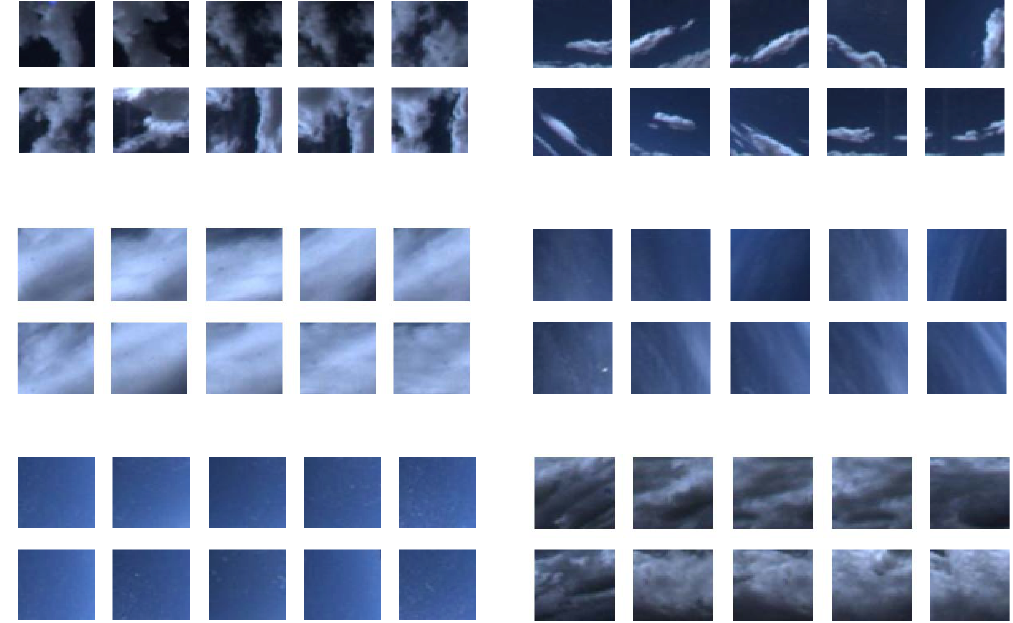
Figure 5. Samples of image patches randomly selected from certain clusters. All images in a cluster are assigned with an identical label of